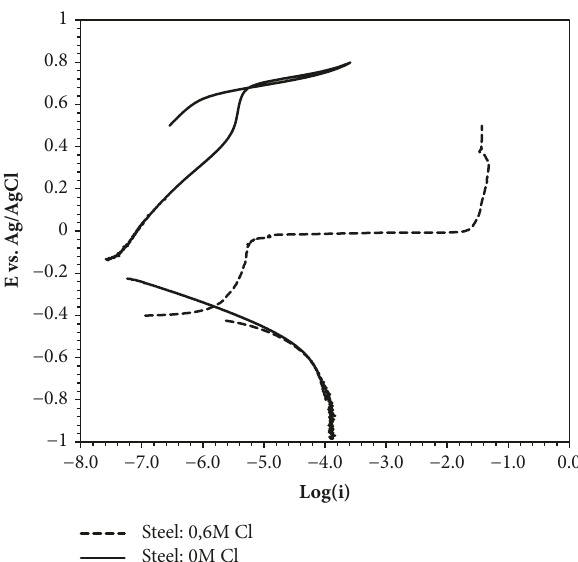
Figure 8: Anodic and cathodic potentiodynamic potential curves for the iron oxides exposed in saturated Ca(OH) 2 solution with 0.6 M Cl −